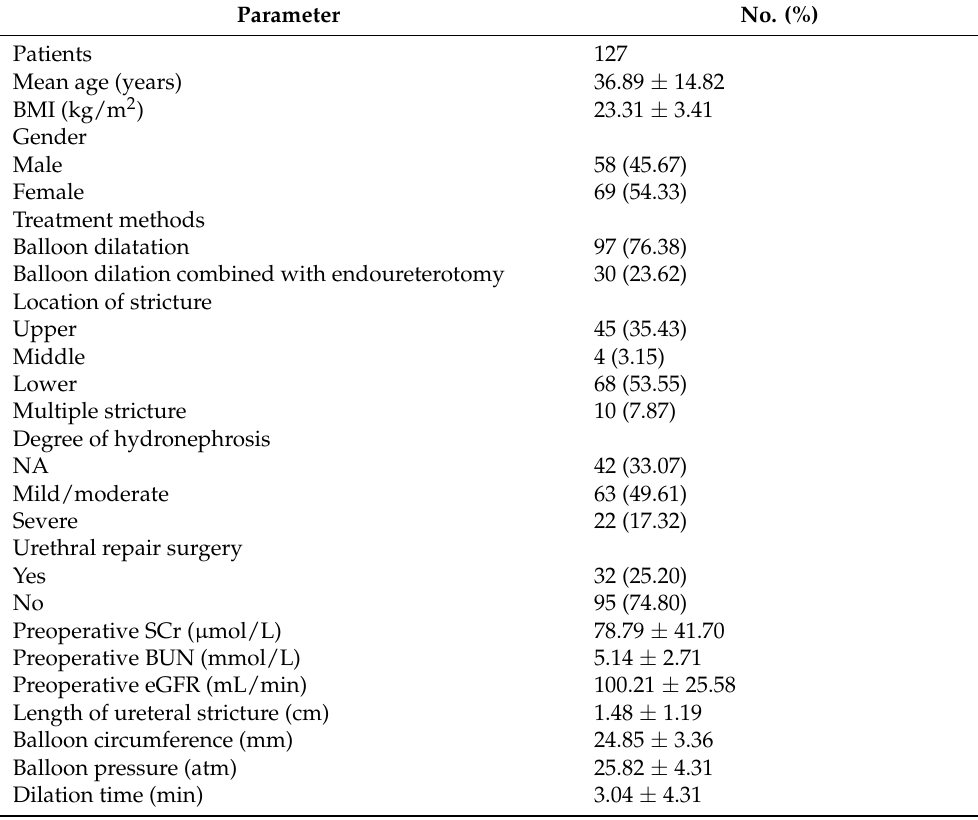
Table 1. Patient